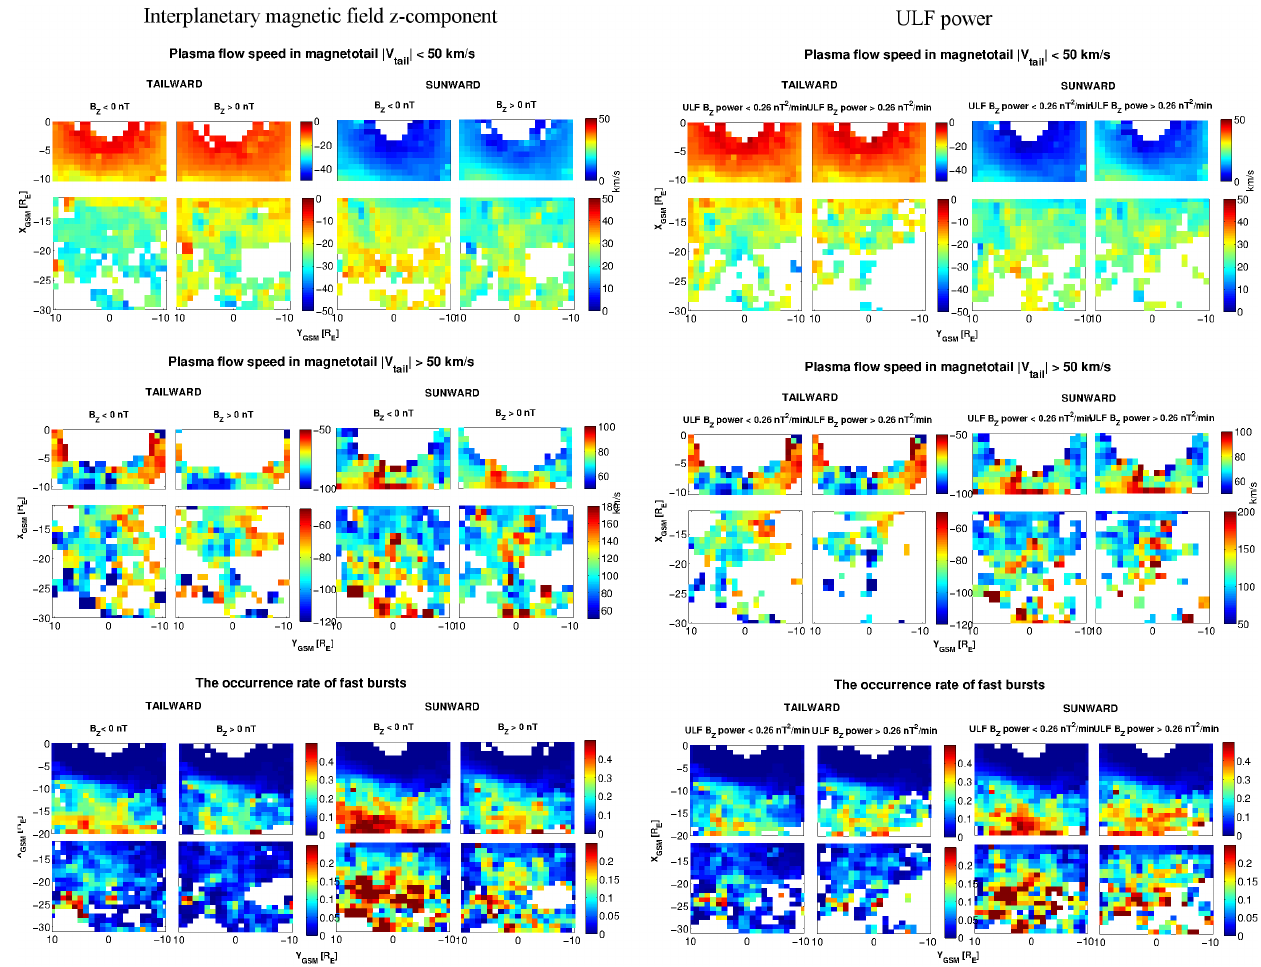
Figure 7. Average plasma flow pattern for slow ( | V tail | < 50kms − 1 , top panels) and fast flows ( | V tail | > 50kms − 1 , middle panels), ratio between the time steps when tail flow bursts exceeded 50kms − 1 (bottom panels, region 0 >X> − 20 R E ) or 100kms − 1 (bottom panels, region − 20 >X> − 30 R E ), and all time steps when the data points are divided into groups based on the interplanetary magnetic field z component and ULF B Z power. The limit for the 1h sliding average B Z and ULF power values are written above the maps. The tailward and sunward flows are shown